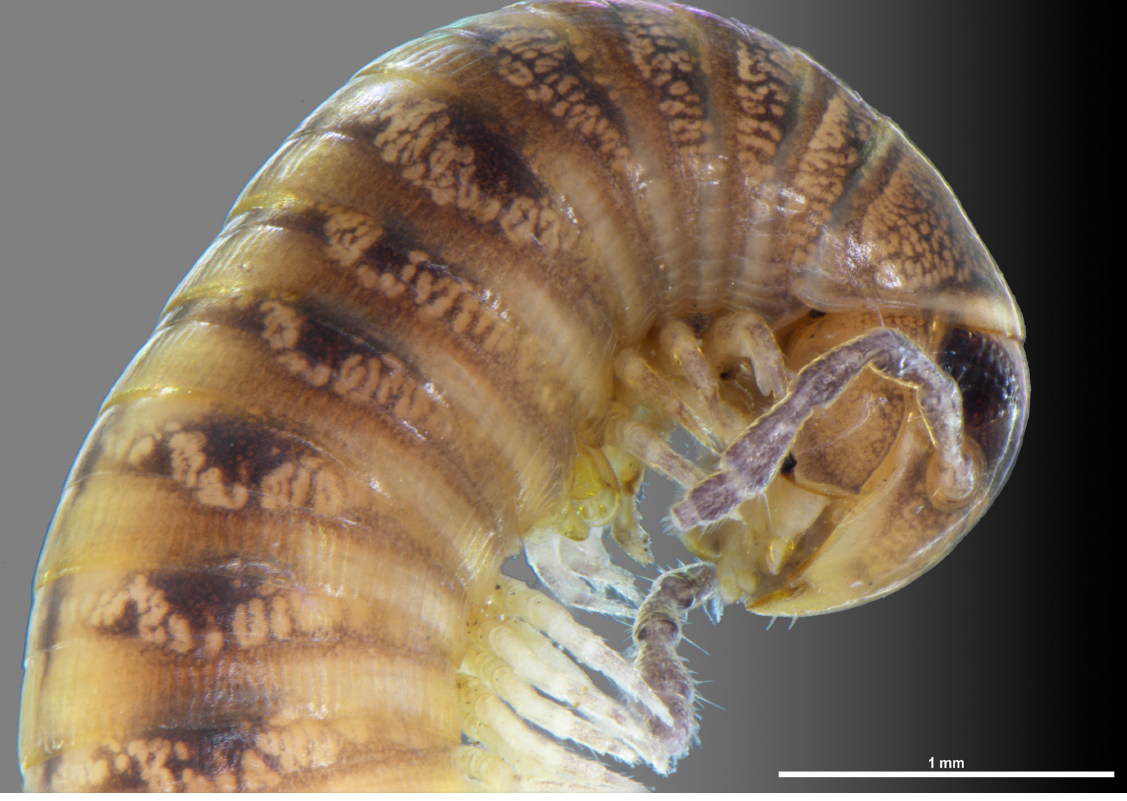
Fig. 22. Ommatoiulus stellaris sp. nov. Paratype ♂, head and anteriormost